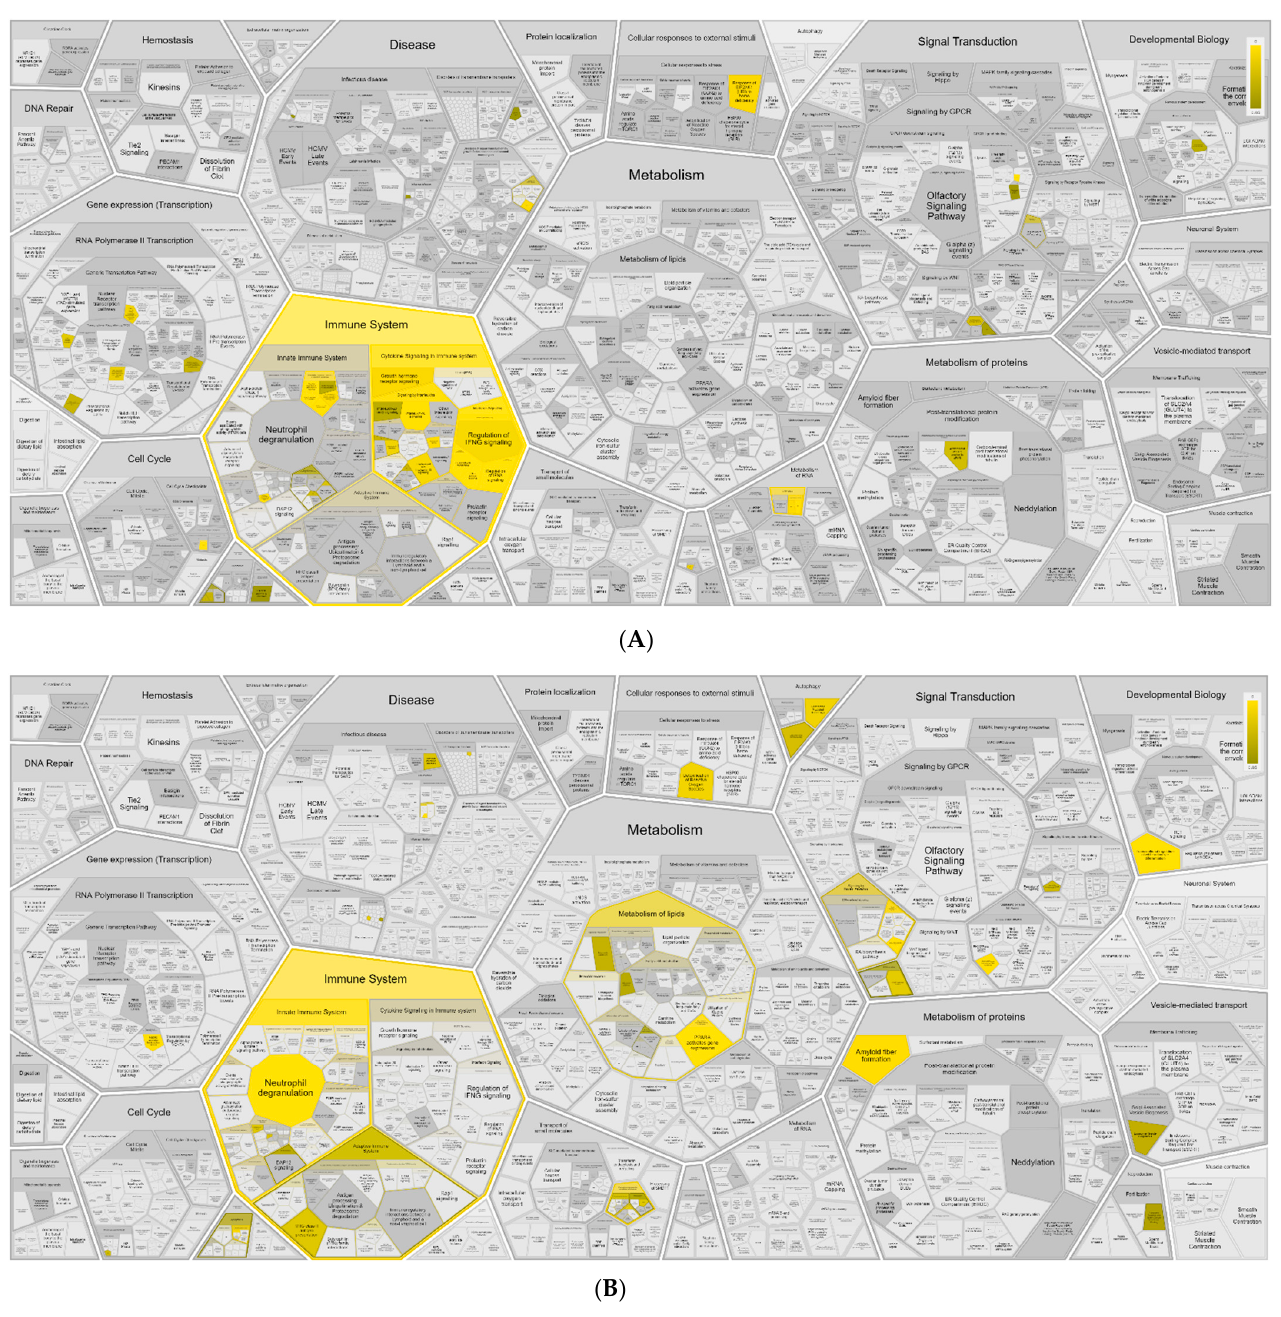
Figure A6. Functional analysis of DEGs identified by RNA-Seq on Reactome. Functions of DEGs upregulated ( A ) and downregulated ( B ) by I-TBEV treatment.